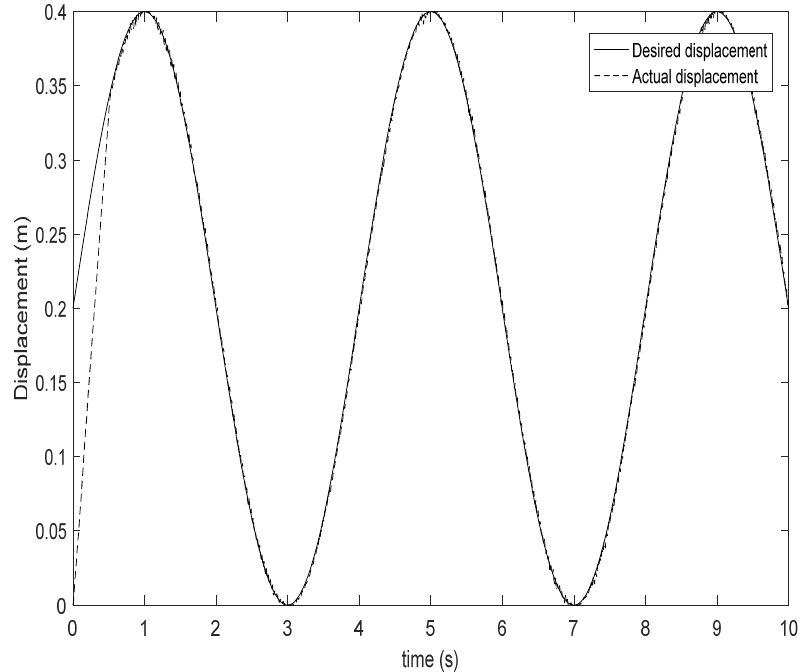
Figure 5. Displacement tracking trajectory of SMC algorithm using adaptive reaching law.